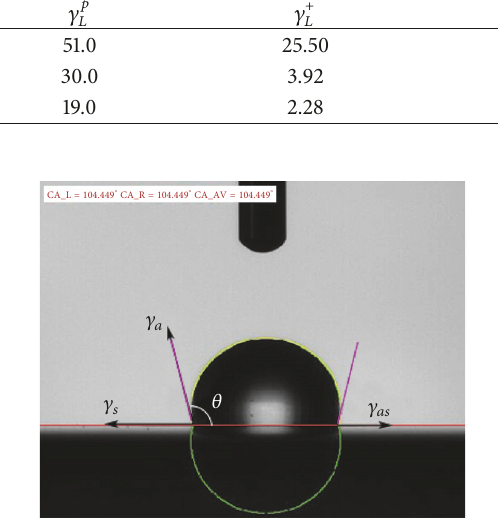
Figure 3: Schematic of the contact angle formed between a probe liquid and asphalt